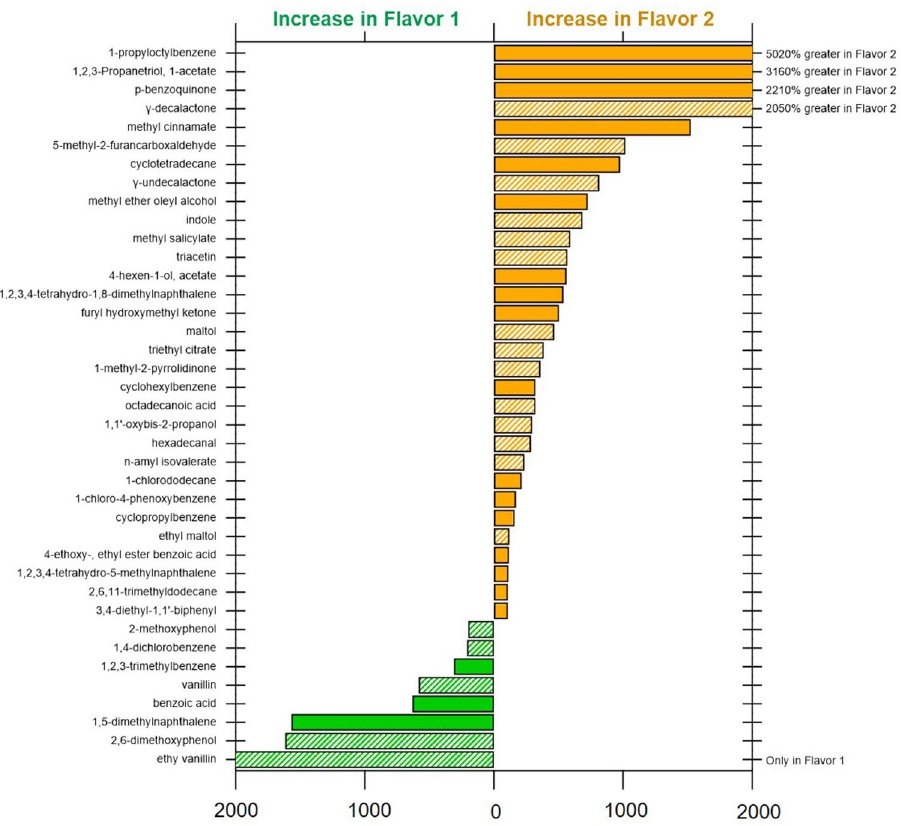
Figure 2. Percent difference in concentration of the top 40 identified compounds in suspect screening by gas chromatography–mass spectrometry comparing electronic cigarette (ECIG) aerosol of ECIG-flavor-1 and ECIG-flavor-2 (both without nicotine) generated at 40 W. All compounds with twofold difference between flavors included. Shaded bars indicate flavor or fragrance-related